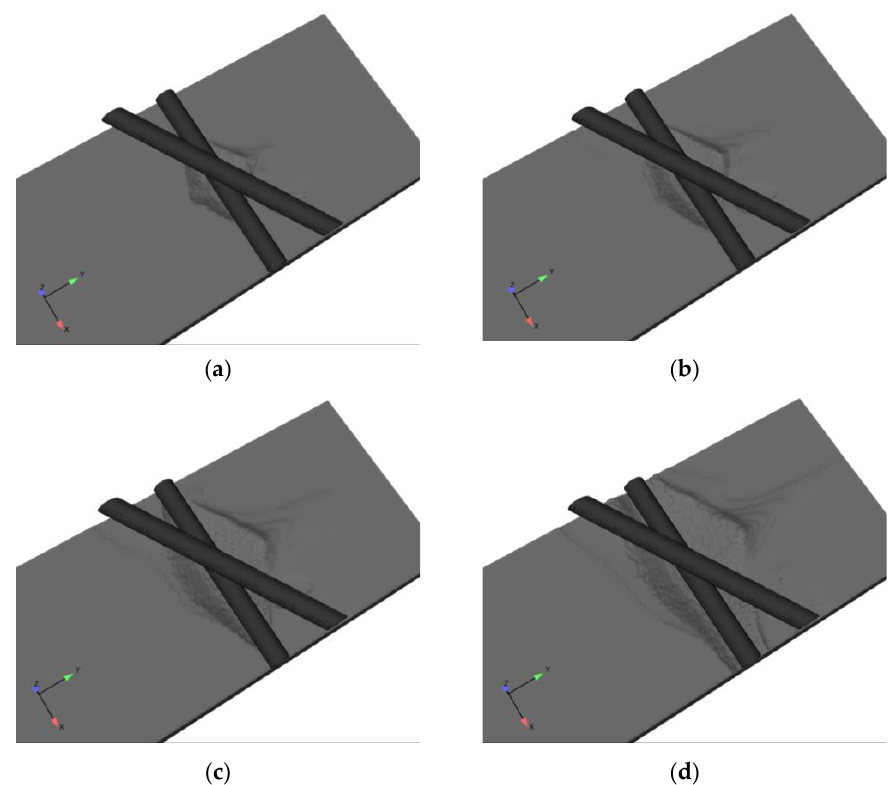
Figure 7. The 3D profiles of scour hole for α = 30°: ( a ) t = 0 s; ( b ) t = 100 s; ( c ) t = 200 s; ( d ) t = 350 s. Figure 8. The 3D profiles of scour hole for α = 30 ◦ : ( a ) t = 0 s; ( b ) t = 100 s; ( c ) t = 200 s; ( d ) t = 350